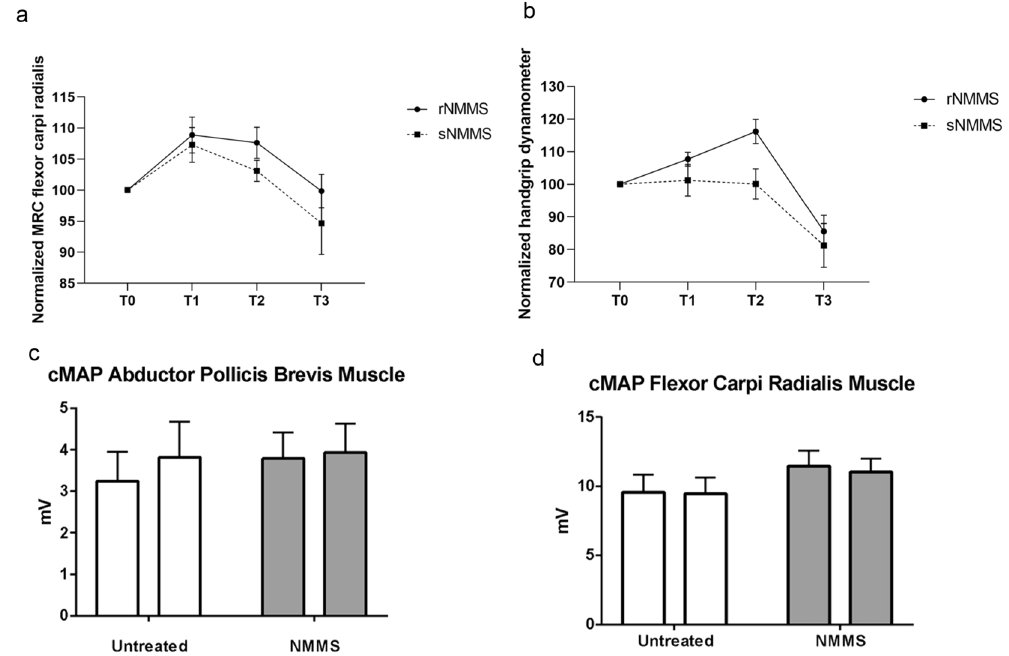
Figure 3. Significant improvement in muscle strength of the flexor carpi radialis muscle. ( a ) Muscle strength was tested by means of the MRC Muscle Scale and ( b ) handgrip dynamometer after NMMS. No significant improvement in muscle strength was observed in the control group. ( c ) No significant difference in cMAP amplitudes was observed before and after NMMS in the APB and ( d ) flexor carpi radialis muscles after median motor nerve stimulation at the elbow (Data represent mean ±